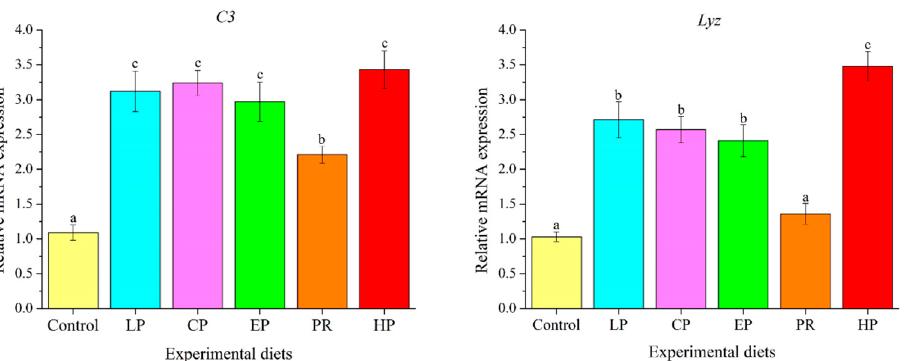
Figure 8. Effects of different diet treatments on the expression of immune-related genes in the liver of Oncorhynchus mykiss . Values are presented as mean ± SE, n = 12. The superscript letters indicated significant differences at p < 0.05.